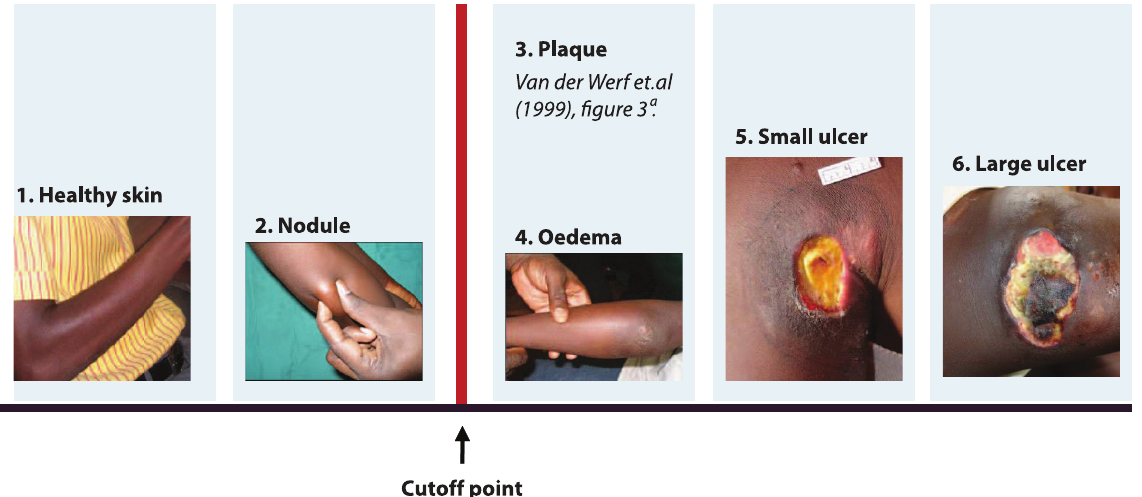
Figure 3. Skin pictures (WHO) shown to respondents to estimate pre-hospital delay. a From The Lancet, 354, Tjip S Van der Werf, Winette TA Van der Graaf, Jordan W Tappero, Kingsley Asiedu, Mycobacterium ulcerans infection, 1013–1018, 1999 [39].